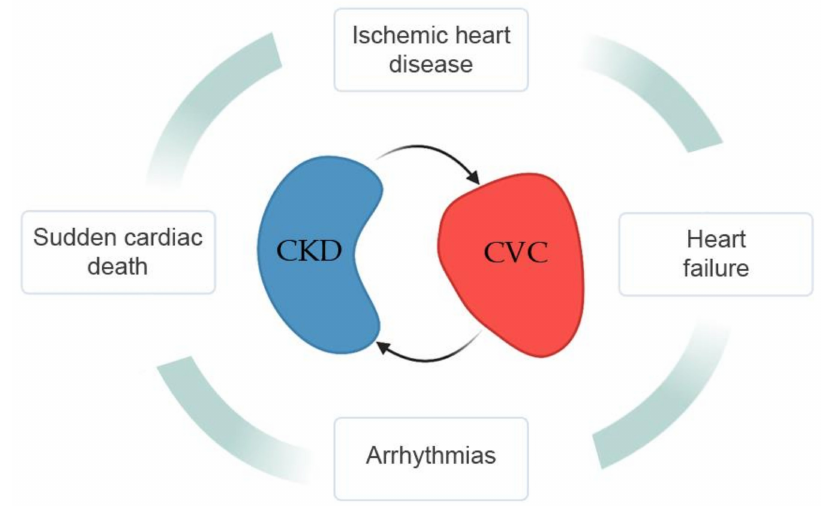
Figure 2. The four main manifestations of type-4 cardiorenal